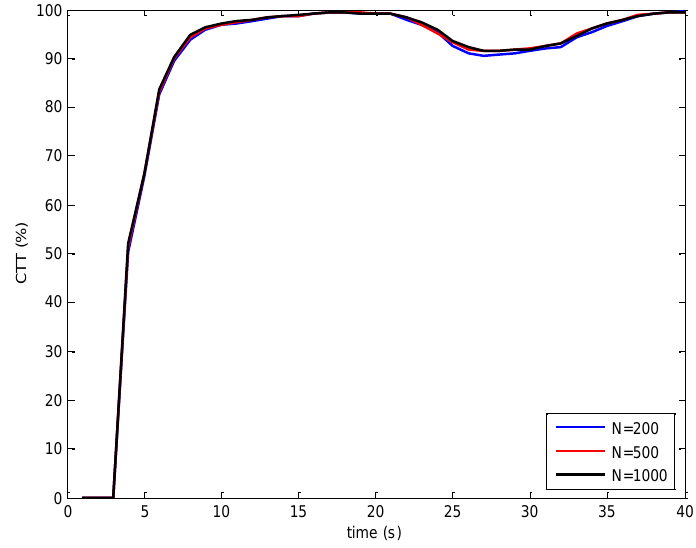
Figure 5. Confirmed true track (CTT) rate for different Markov Chain (MC) lengths. Table 3. Statistics for different MC lengths.